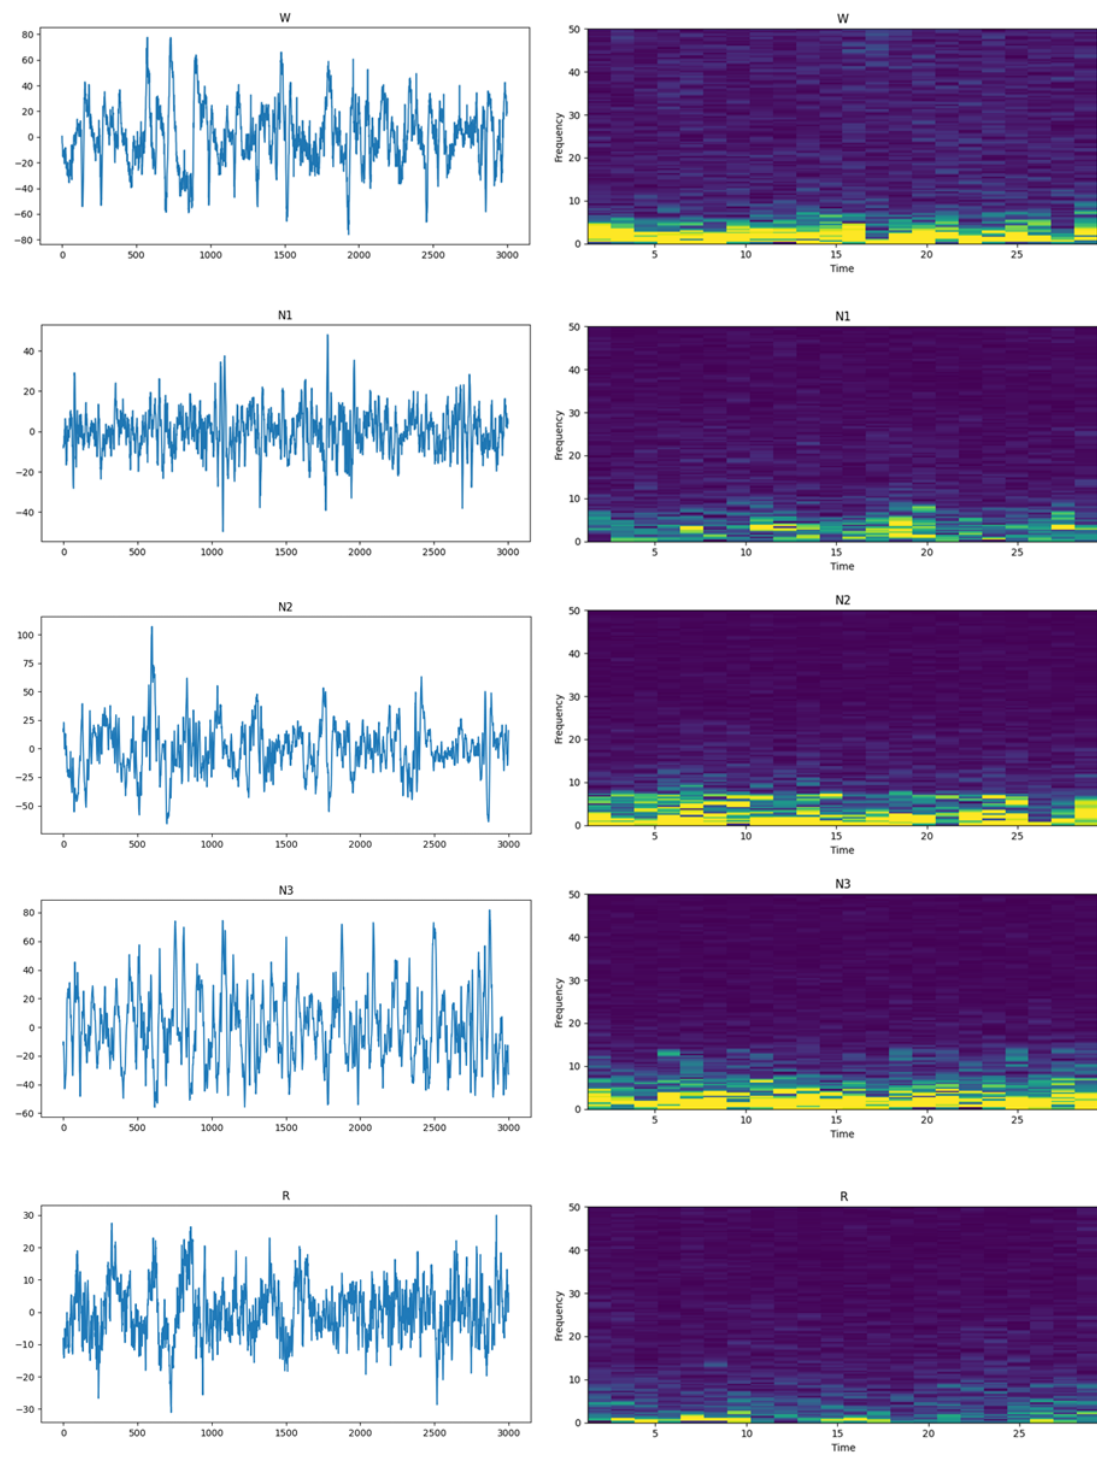
Figure 1. EEG epochs in the time and frequency domain. From top to bottom are stages W, N1, N2, N3 and REM. EEG epochs in the time domain are displayed on the left and the short-time Fourier transform (STFT) of EEG epochs is shown on the right. The yellow color represents higher amplitudes and the blue color indicates lower amplitudes.